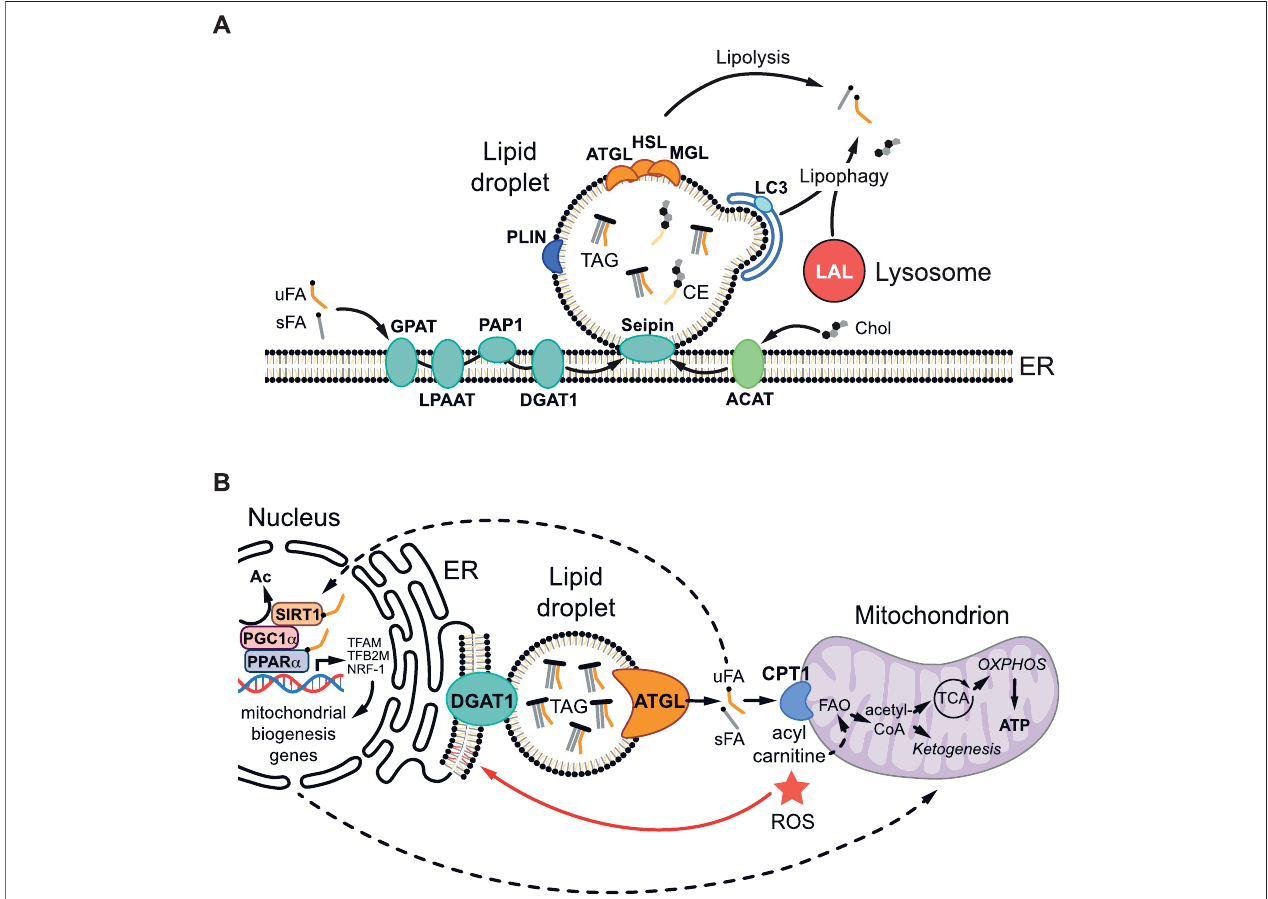
FIGURE 1 | Lipid droplet metabolism and mitochondrial regulation. (A) During lipid droplet (LD) biogenesis, triacylglycerols (TAG) and cholesterol esters (CEs) are synthesized in the endoplasmic reticulum (ER). TAGs are generated from unsaturated and saturated fatty acids (uFAs and sFAs respectively) and glycerol-3-phosphate via four sequential enzymatic reactions involving glycerol-3-phosphate acyltransferase (GPAT), lysophosphatidic acid acyltransferase (LPAAT), phosphatidate phosphatase 1 (PAP1), and diacylglycerol acyltransferase 1 (DGAT1). CEs are generated by acyl-CoA cholesterol acyltransferase (ACAT), which esteri fi es FAs to cholesterol(Chol).ER-residentenzymeSeipincontrolsthechannellingofnewlysynthesizedneutrallipidsintothegrowingLDcore.TAGandCEaccumulatebetweenthe two membrane lea fl ets of the ER bilayer, forming a nascent lipid lens that buds off as a LD. The LD surface is a phospholipid monolayer coated with a speci fi c set of proteins including perilipins (PLIN), which maintain structure and regulate lipolysis, as well as adipocyte triglyceride lipase (ATGL), hormone sensitive lipase (HSL) and monoacylglycerol lipase (MAGL), which sequentially hydrolyze TAG to liberate free FAs via neutral lipolysis. During lipophagy, lysosomal acid lipases (LALs) hydrolyze TAG in the lysosome via acid lipolysis after phagophore engulfment involving microtubule-associated protein light chain 3 (LC3). (B) LDs can protect against lipotoxicity and high reactive oxygen species (ROS) via multiple non-mutually exclusive mechanisms. LDs buffer cytoplasmic free FA levels and generate lipid ligands/signals that stimulate the nuclear receptor peroxisome proliferator-activated receptor α (PPAR α ), a partner of PPAR γ -Coactivator-1 α (PGC1 α ), either via direct binding or indirectly via interaction withthesirtuin1(SIRT1)deacetylase.SIRT1 deacetylaseremoves anacetylgroup(Ac) andactivatesPGC1 α allowingittopartnerwithPPAR α topromote the transcription of target genes involved in mitochondrial biogenesis and function, including Transcription factor A mitochondrial (TFAM), Transcription factor B2 mitochondrial (TFB2M), and Nuclear respiratory factor 1 (NRF-1). LDs also ef fi ciently deliver FAs to mitochondria, where carnitine palmitoyltransferase (CPT1), converts them into acylcarnitines for fatty acid oxidation (FAO) to produce adenosine triphosphate (ATP), via the tricarboxylic acid (TCA) cycle and oxidative phosphorylation (OXPHOS), and also ketone bodies (ketogenesis). In addition, the environment of the LD core may minimize the potentially toxic effects of oxidized polyunsaturated FAs by protecting against lipid peroxidation or by sequestering already peroxidated lipids.